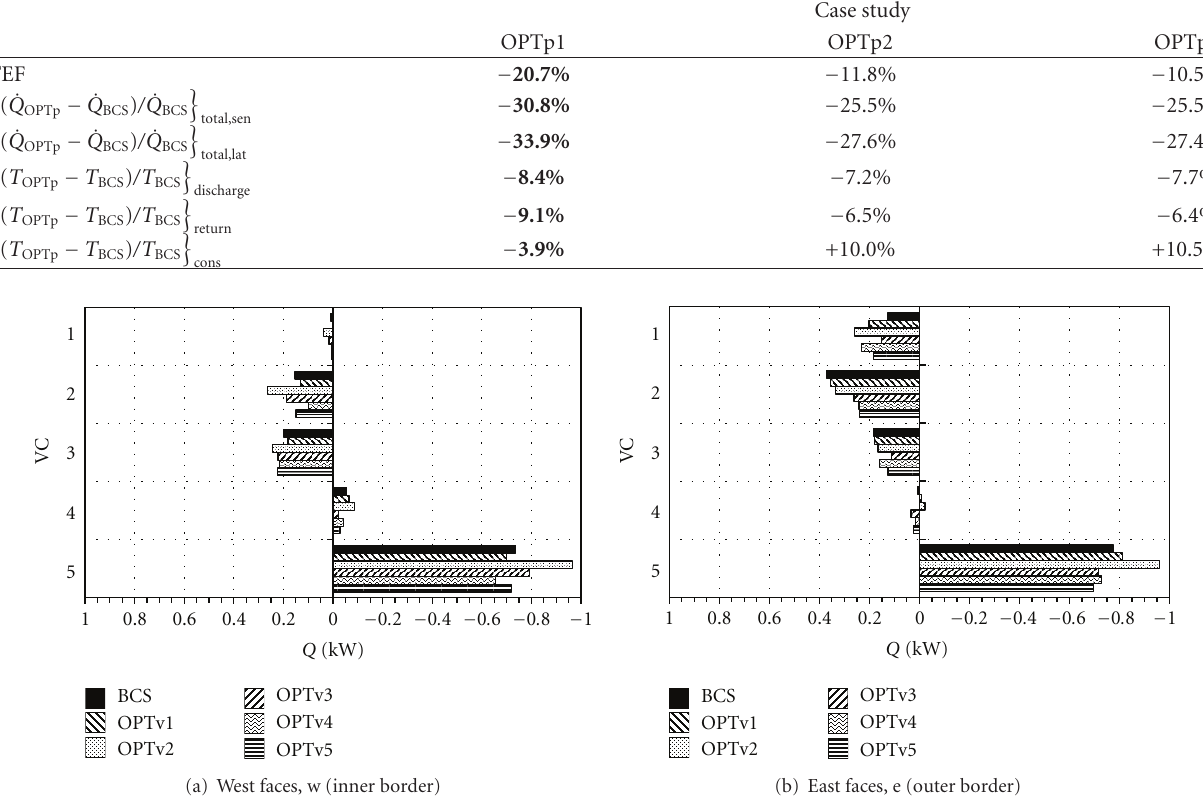
Figure 2: Enthalpic flow rate predictions across West (inner border) and East (outer border) of the air curtain control volumes, per unit length—OPTv cases study.